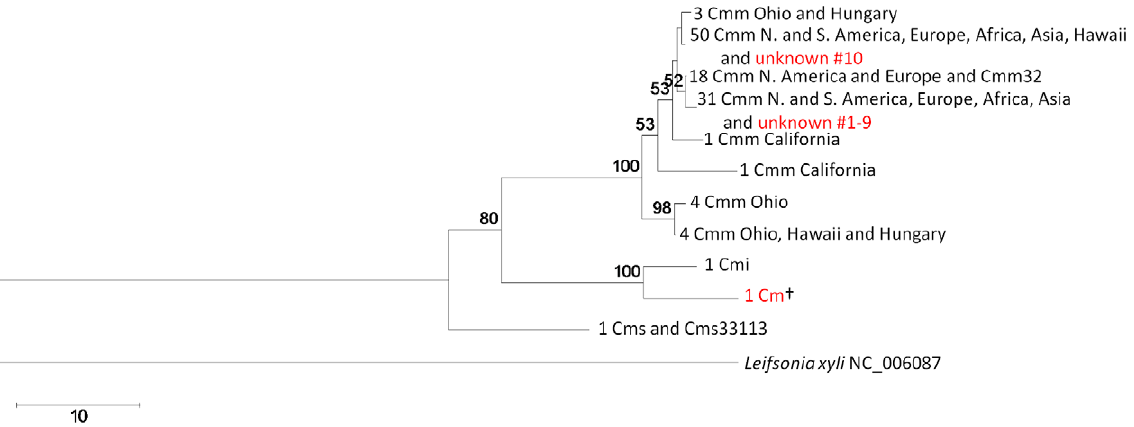
Figure 5. The RIF marker separates Clavibactermichiganensis strains into the three subspecies. The rooted neighbor-joining cladogram was constructed from 114 characterized Clavibacter strains from the PBC (Table 2), two reference strains from GenBank (see Table 1 for strain names) and the outgroup Leifsonia xyli . Identical sequences are represented only once and the number of sequenced strains is indicated on each leaf. Bootstrap values . 50% (shown at the node) are expressed as a percentage of 5,000 replicates. Red text indicates C. michiganensis strains with no previous subspecies designation. Cm { is a non-pathogenic strain isolated from tomato that is most similar to Cmi. Unknowns # 1-10 were isolated from a recent bacterial canker outbreak of tomato (see text) and perfectly match two of the Cmm RIF reference sequences. Cmm: C. michiganensis subsp. michiganensis . Cmi: C. michiganensis subsp. insidiosus . Cms: C. michiganensis subsp. sepedonicus .